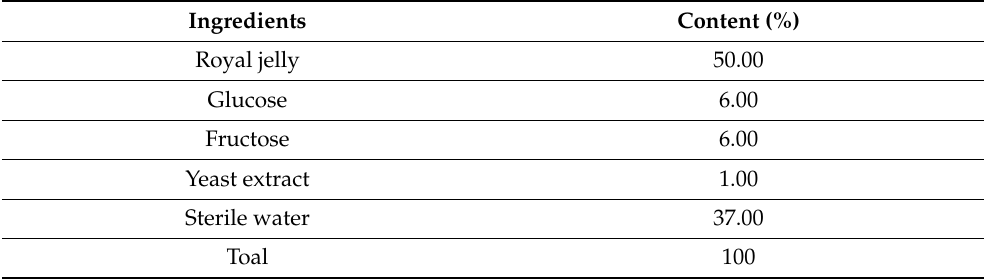
Table 1. Composition of larvae